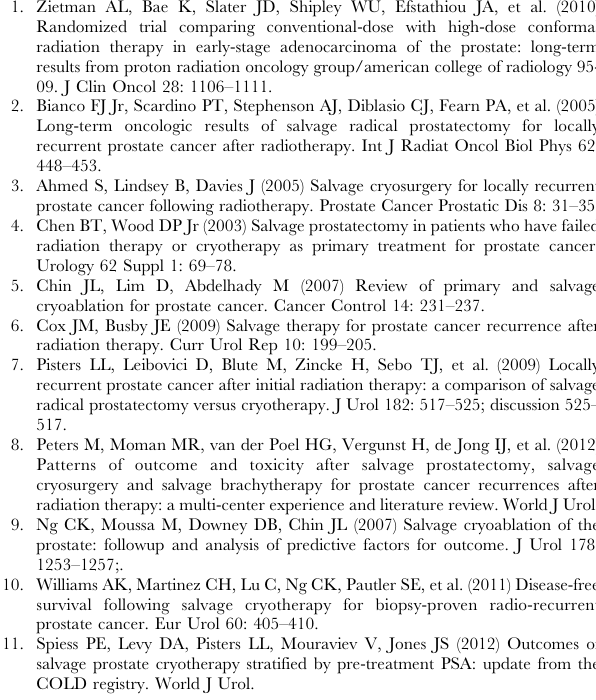
Table S2 Breakdown of patient numbers for individual survival analysis in Figure